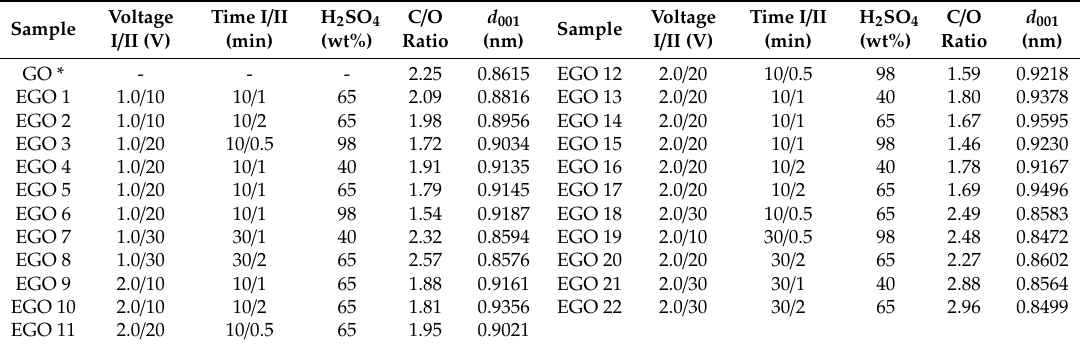
Table 1. Nomenclature and experimental conditions for the di ff erent exfoliated graphene oxide (EGO)